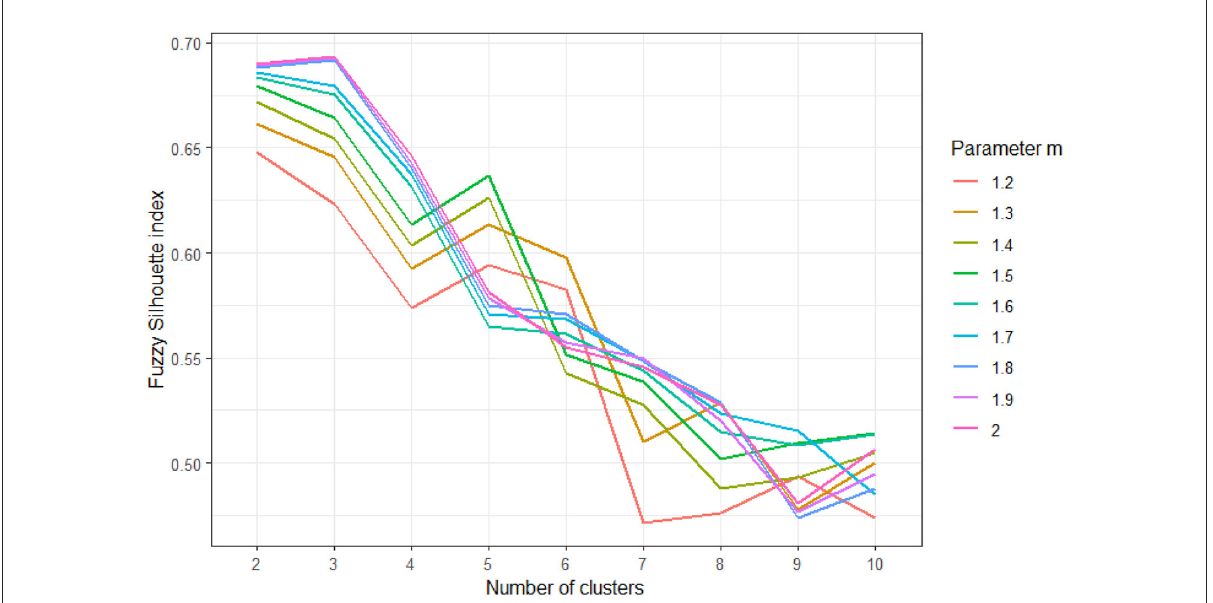
FIGURE1 Results of fuzzy silhouette indices used to determine appropriate clustering solution, for varying number of clusters (k = 2–10) and varying values of fuzziness parameter m (m = 1.2–2). Higher fuzzy silhouette values indicate more appropriate clustering solution.